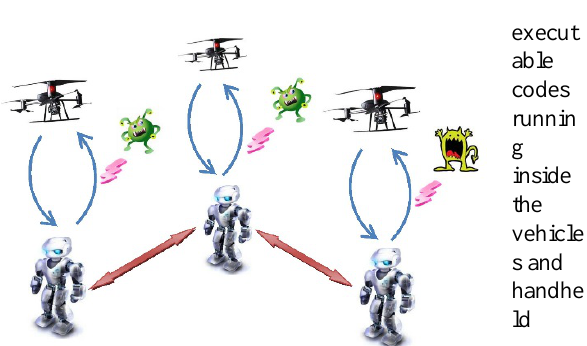
Figure 1: Unmanned-vehicle-operator-network